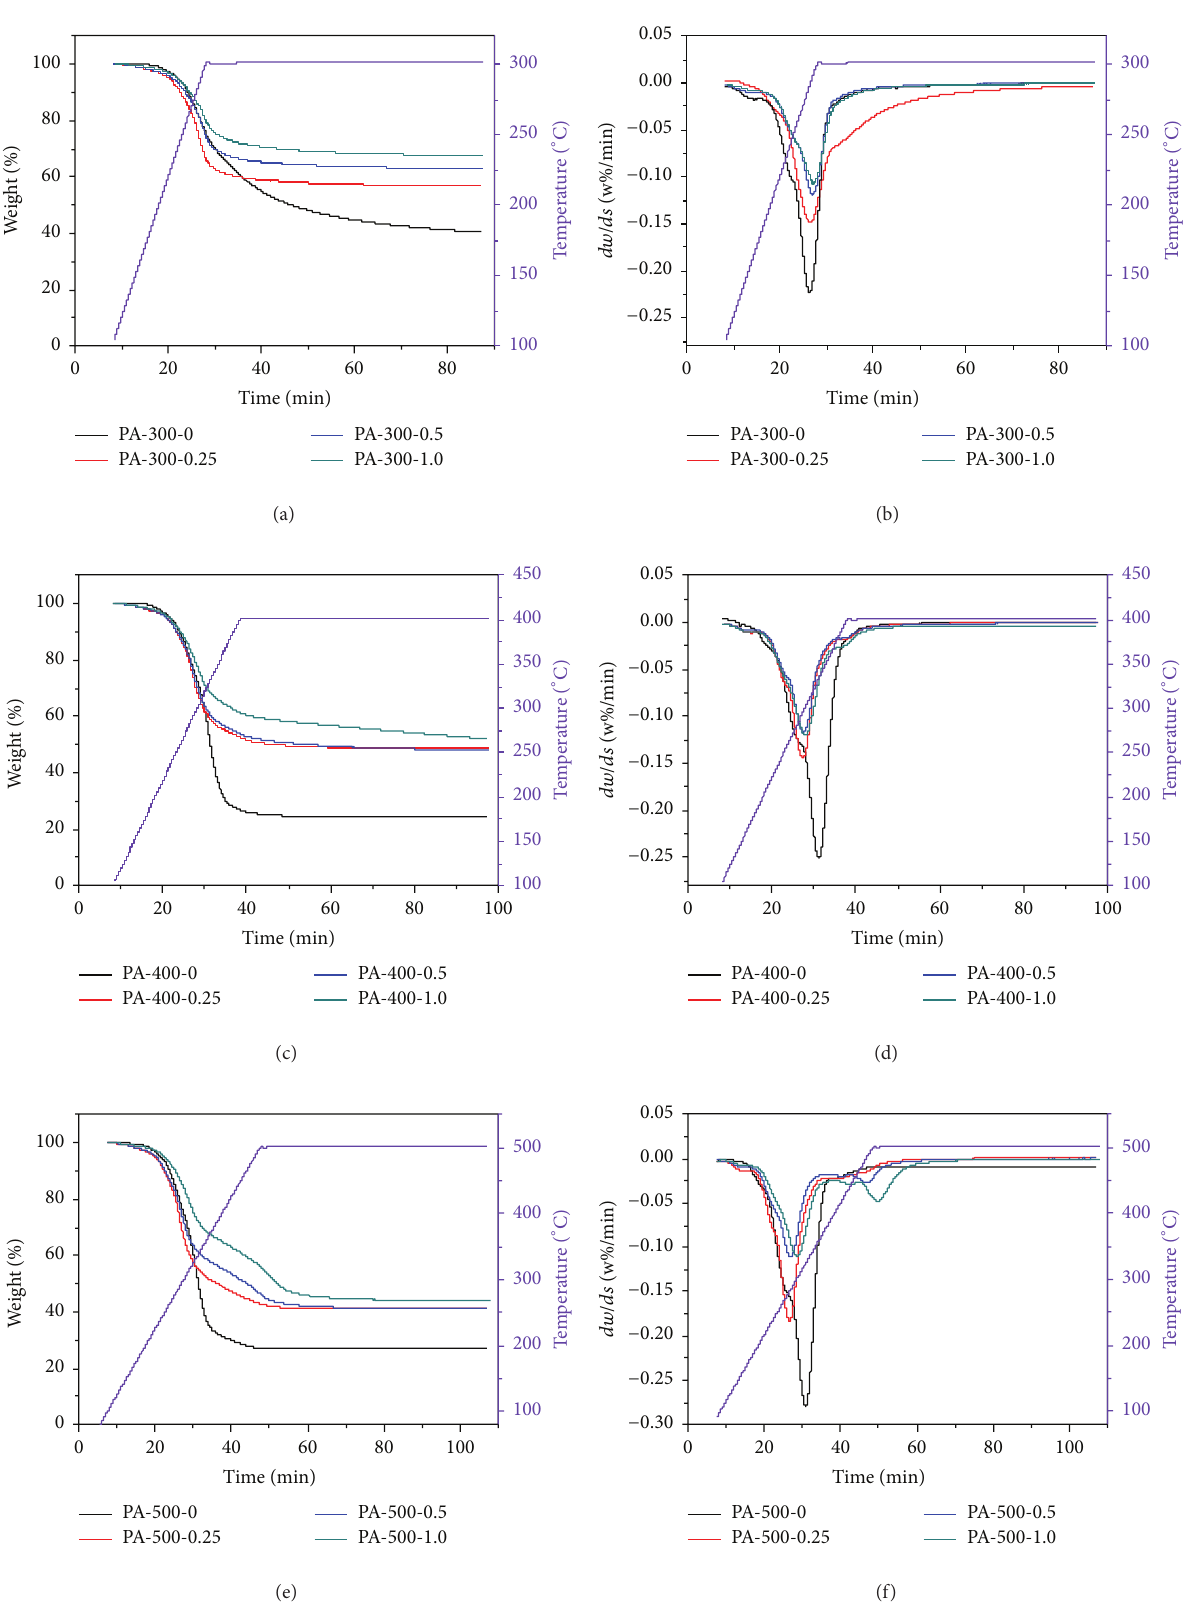
Figure 1: Thermogravimetric analysis (TGA) and derivative thermogravimetric (DTG) curves of PA- 𝑋 - 𝑌 samples. (a) TGA curves of PA- 300- 𝑌 samples; (b) DTG curves of PA-300- 𝑌 samples; (c) TGA curves of PA-400- 𝑌 samples; (d) DTG curves of PA-400- 𝑌 samples; (e) TGA curves of PA-500- 𝑌 samples; (f) DTG curves of PA-500- 𝑌